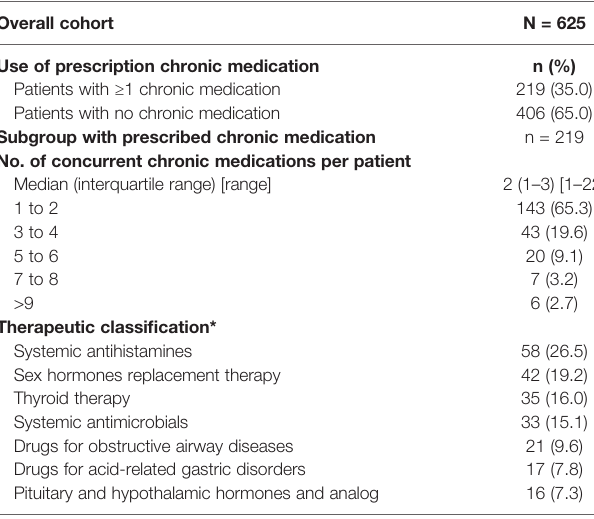
TABLE 2 | Pattern of prescription chronic medication